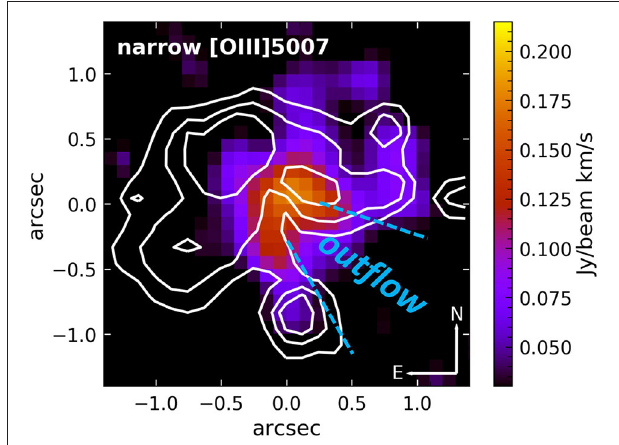
FIGURE 3 | The color background image CO(3-2) flux map of LBQS0109, while white contours indicate the narrow [O III ] λ 5007 emission tracing star-formation emission in the host galaxy. Contours are in steps of 1 σ = 0.4 × 10 − 18 erg / s / cm 2 , starting at 2 σ . The blue dashed line indicates the direction of the AGN-driven outflow inferred from the velocity map of the broad components. Star-formation and molecular gas emission is faint/absent in the outflow region. The figure is an adaptation from Carniani et al. (2017). Credit: Carniani, A&A, 605, A105, 2017, reproduced with permission © ESO.